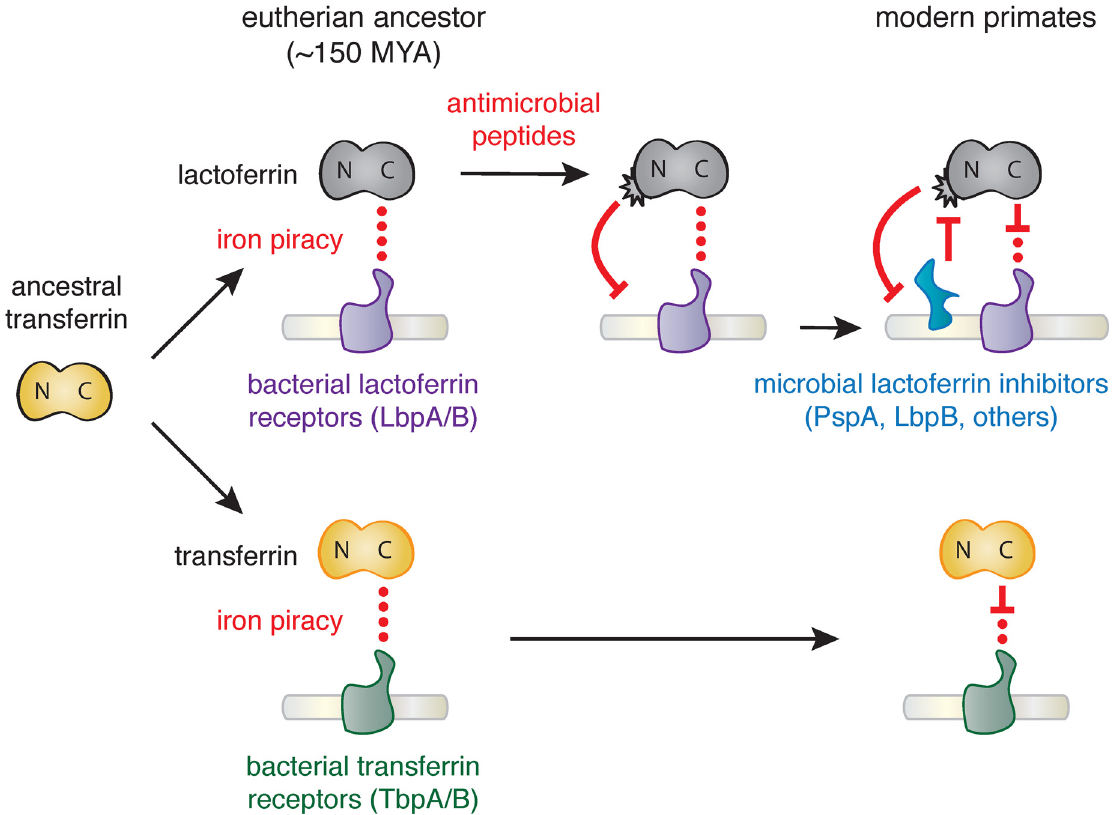
Fig 4. Model of lactoferrin evolution and genetic conflicts with pathogens. Following a duplication of the transferrin gene in the ancestor of eutherian mammals, interactions between the transferrin (yellow) C lobe and the bacterial transferrin receptors such as TbpA (green) led to the emergence of a molecular arms race. In contrast, while lactoferrin has likely also been engaged in evolutionary conflicts with pathogen iron acquisition receptors like LbpA (purple), the emergence of antimicrobial peptide activity in the N lobe would have provided novel defense activity against pathogens targeting lactoferrin as an iron source. This function would have led to the emergence of pathogen inhibitors of lactoferrin antimicrobial peptide activity (such as PspA or LbpB), which have dominated subsequent evolutionary conflicts localized to the lactoferrin N